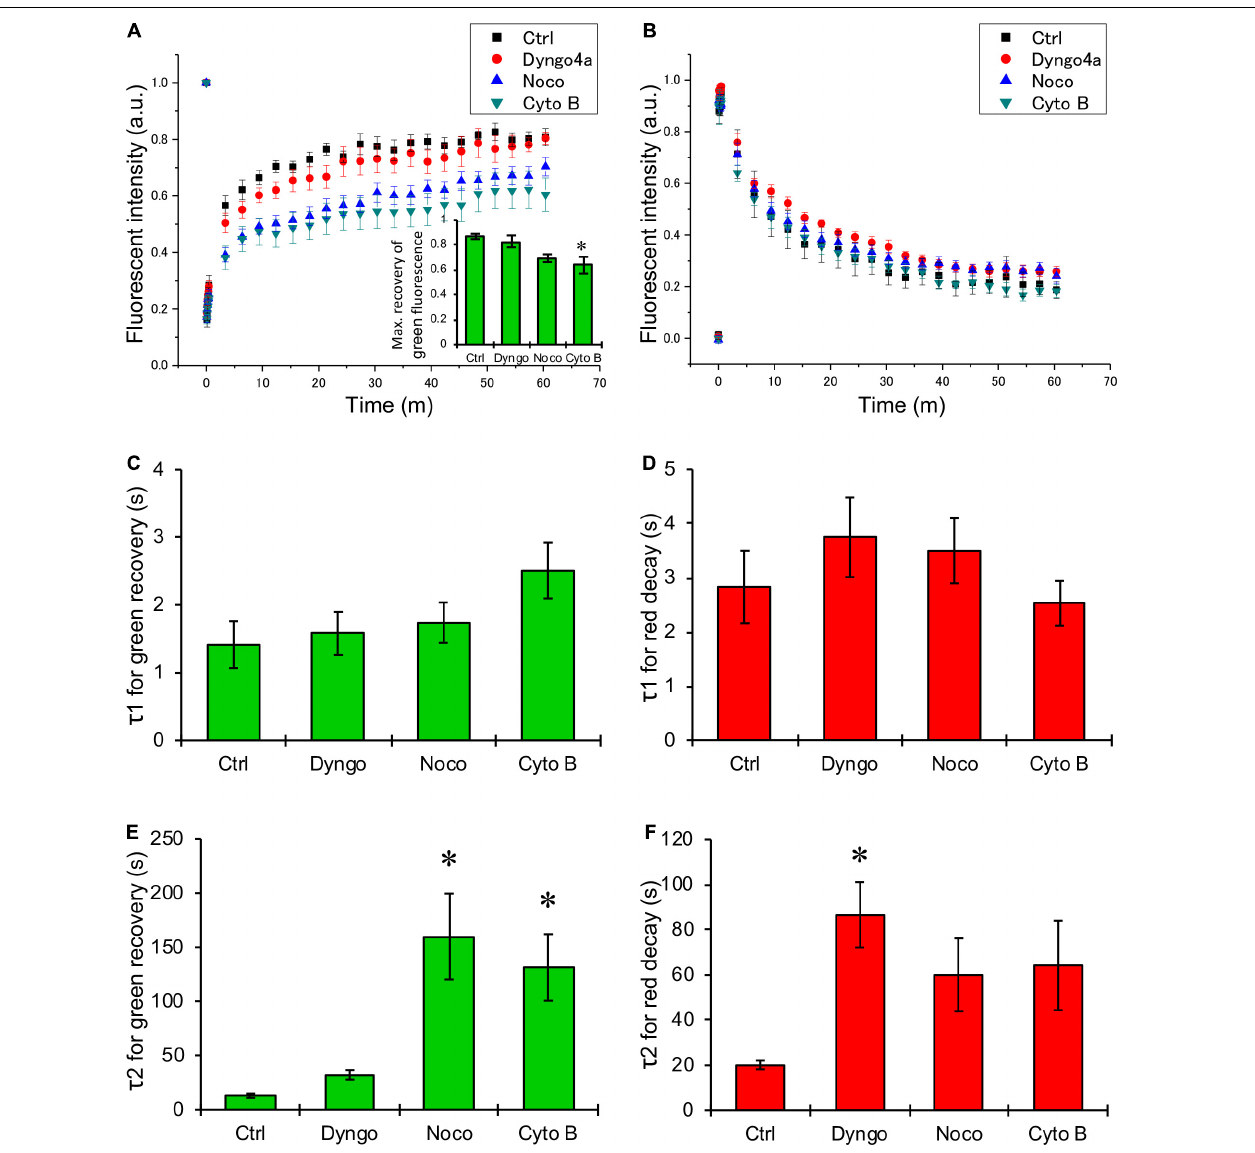
FIGURE 3 | Quantification of changes in green and red fluorescence of K IR 2.1-Dendra2. (A,B) Summarized data of time-dependent recovery in green fluorescence (A) and decay of red fluorescence (B) . Black boxes are for control ( n = 14), and red circles, blue triangles, green triangles are for the data from the cells treated with Dyngo-4a ( n = 15), Nocodazole ( n = 20), Cytochalasin B ( n = 17), respectively. (C,D) Summarized data of τ 1 (C) and τ 2 (D) , fast and slow component of time constant for the recovery of green fluorescence after photoconversion, respectively. (E,F) Summarized data of τ 1 (E) and τ 2 (F) , fast and slow component of time constant for the decay of red fluorescence after photoconversion, respectively. ( A , inset) The maximum recovery rate of green fluorescence after photoconversion. ∗ : p < 0.05 vs. control (one-way